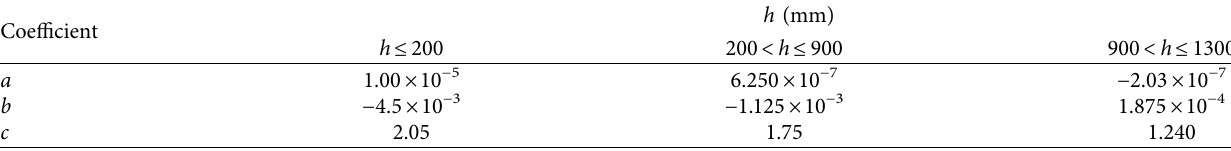
Table 4: The coefficient of a , b , and c .